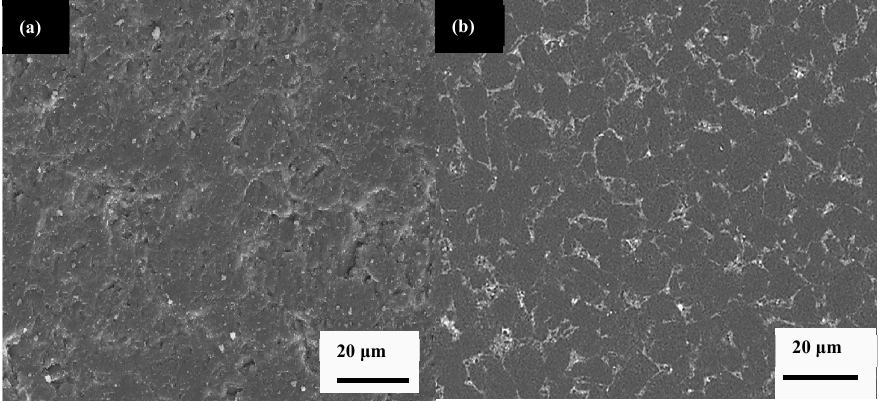
Figure 1. ( a ) Secondary electron SEM image of PcBN; ( b ) backscattered electron SEM image of PcBN.